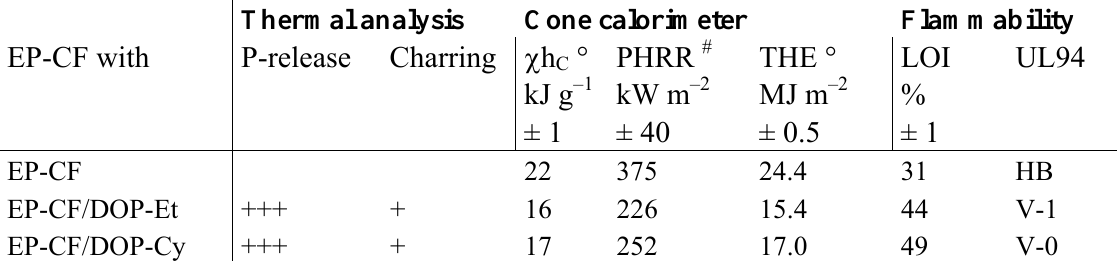
Table 6. Fire behavior of EP-CF, EP-CF/DOP-Et, and